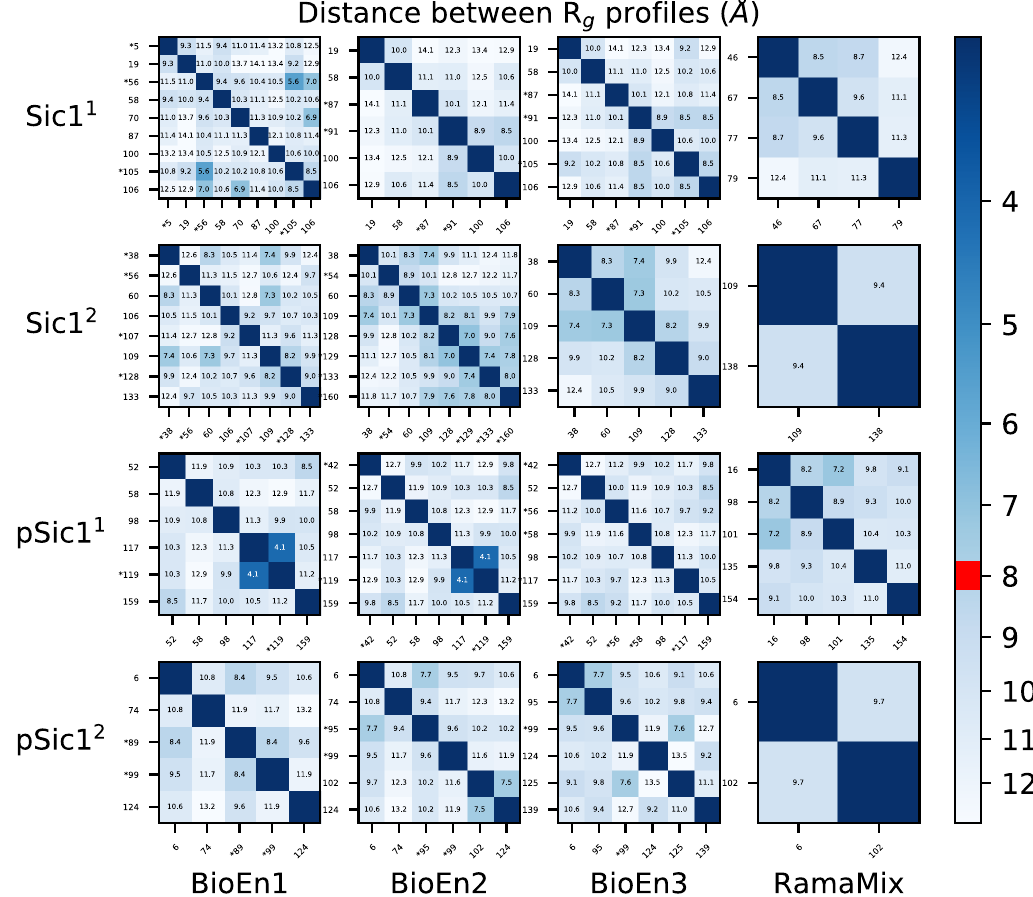
Figure 4. Distances between the profiles P q (Eq. 1) of local gyration radii between the conformations selected from the fit of SAXS curves (BioEn1,BioEn2, BioEn3) or Ramachandran maps (RamaMix). The conformations for which populations smaller than 10% were calculated, are labeled with an asterisk. The diagonals correspond to the comparison of the same conformations and are thus not annotated with distance value. The limit of 8 Å used to display superimposed plots of profiles P q (Fig. 5) is drawn in red on the scale of selected in two distinct BioEn runs: (i) for Sic1 2 , the conformation 106 selected on the SAXS curve BioEn1 compared to the conformations selected on the two other SAXS curves; (ii) for pSic1 2 , the conformation 74, selected in the runs BioEn1 and BioEn2, and compared to the conformations selected from the run BioEn3; (iii) for pSic1 2 , the conformation 139 selected from the run BioEn3, and compared to the conformations from the run BioEn1. Overall, most of the conformations populated more than 10% from the fitting of different SAXS curves display profile distances smaller than 8 Å, supporting a convergence of the profiles in the different fits. On the other hand, the comparison between BioEn and RamaMix fitting (Fig. S11) displays contrasted behaviors between the duplicated TAiBP runs. For Sic1 2 and pSic1 2 , all RamaMix conformations display pro- files closer than 8 Å to the profiles of BioEn conformations. For pSic1 1 , this is also the case for three RamaMix conformations (16, 98, 101) over five. For Sic1 1 , only the conformation 79 displays profile distances smaller than 8 Å for the three comparisons. Examples of profiles P q superimposition have been chosen accordingly to the values of their distances (Fig. 5) and give an estimation of the connection between the information related to atomic coordinates and the distance between the profiles. These examples represent distances in the 4.05–7.88 Å range. The examination of Fig. 5 reveals that the profile peaks are mostly located at similar places in the protein sequence. This gives a qualitative description of the conformations separated in extended regions (profile maxima) and in aggregated regions (profile minima). The description of IDP conformations by P q profiles permits to detect some convergence between the vari- ous Bioen fits and also between RamaMix and BioEn fit. This is extremely encouraging due to the enormous conformational size and to the heterogeneity of the measurements (SAXS, NMR) used for fitting the populations. Nevertheless, this comparison remains extremely qualitative, and far from any high resolution description. It could represent a starting point for deeper investigation of IDP conformations.